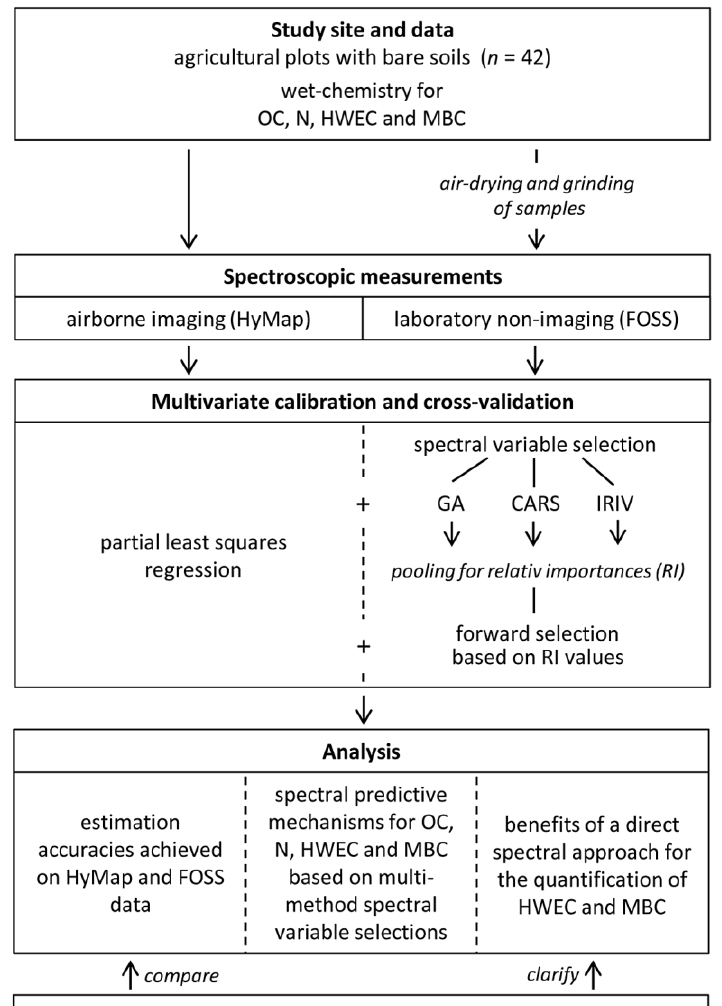
Figure 2. Workflow of the study.